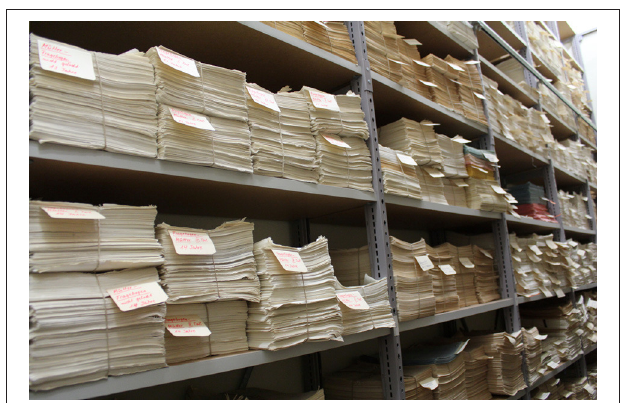
FIGURE 5 | One of the archives hosting the raw data of